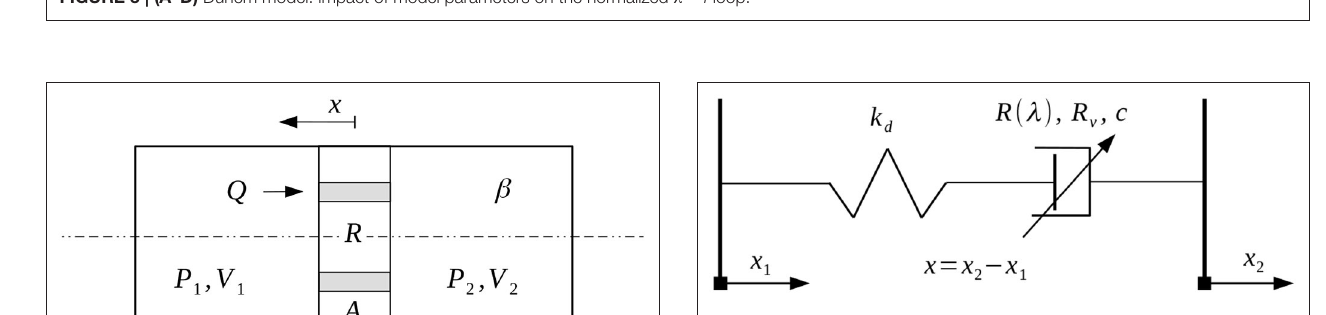
FIGURE 5 | Block diagram of the hysteretic model (gas force not shown); x 1 , x 2